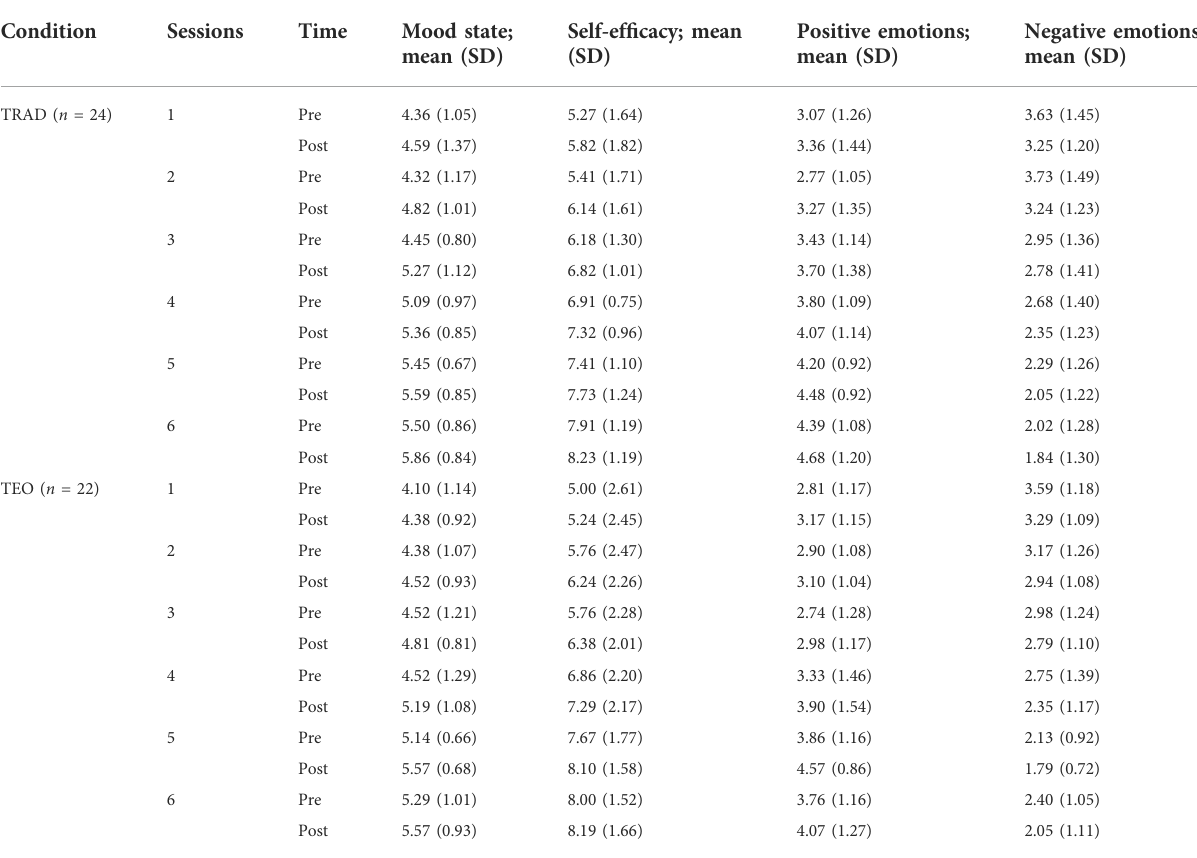
TABLE 3 Means and standard deviations obtained for mood, self-ef fi cacy, and emotional variables in the two experimental conditions from pre-to post-homework time.